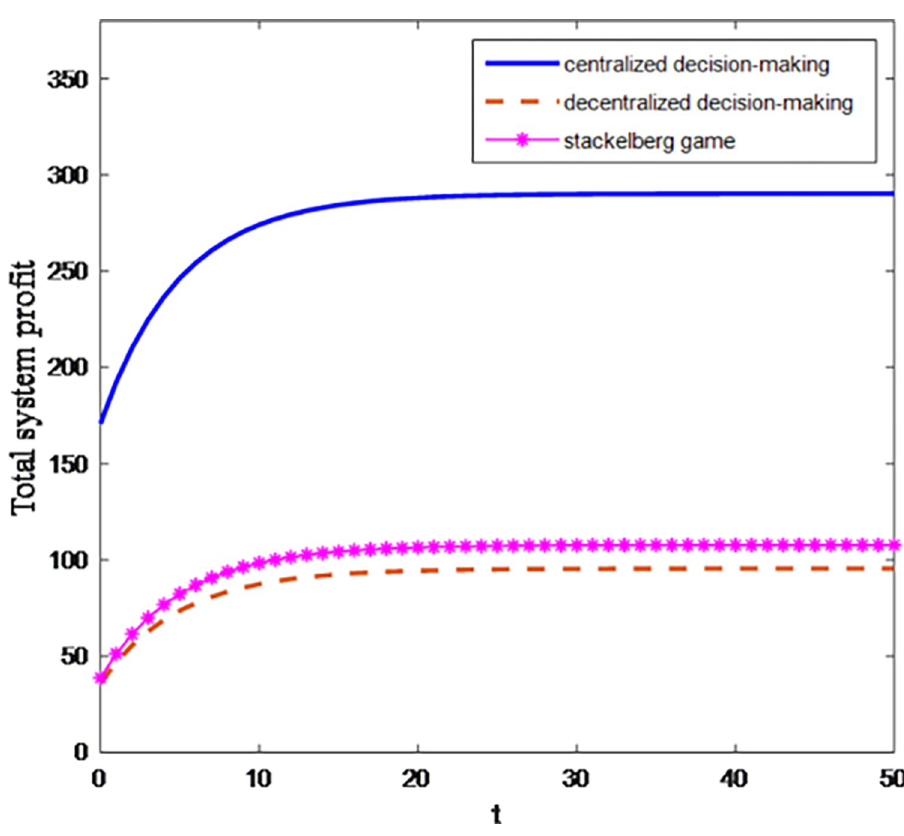
Fig 2. Total profit of the system under three game